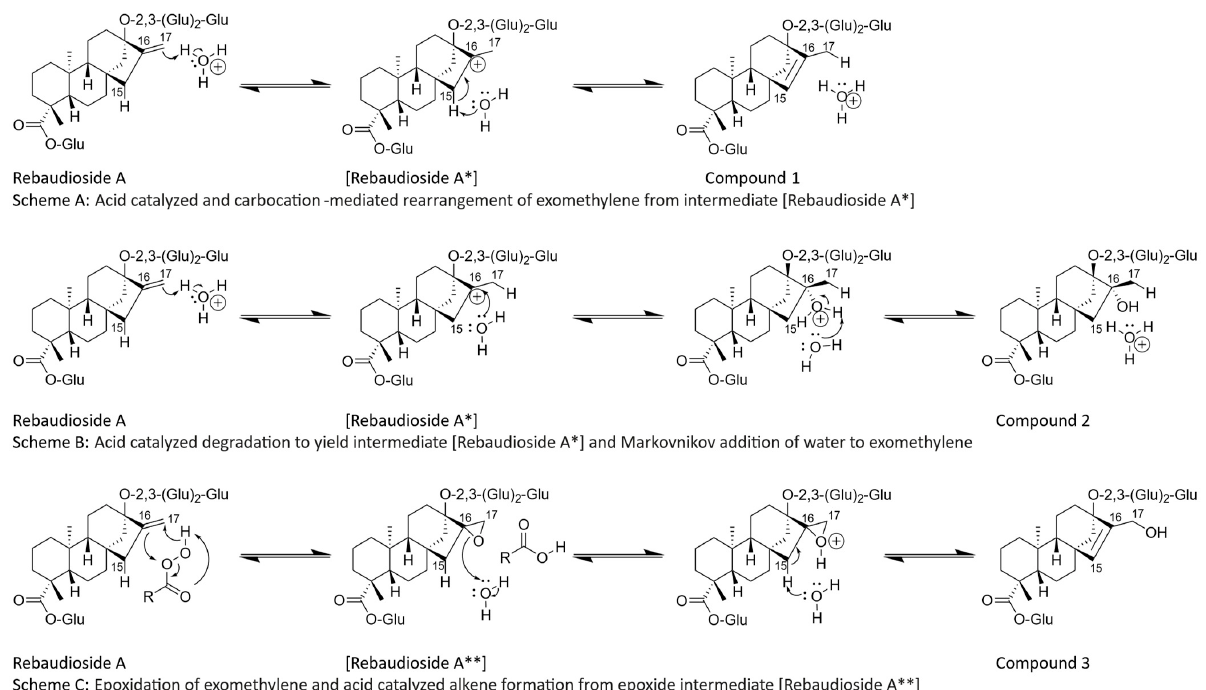
Figure 1. Mechanisms of rebaudioside A degradation.